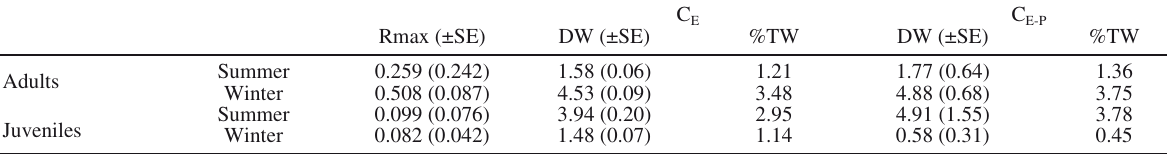
Table 3. – Estimates of gastric evacuation Rmax (h −1 ) and consumption rates C (DW 1000 g –1 wet BW) for sardine adults and juveniles in summer and winter. Consumption values are also expressed as percent total weight (%TW). DW, dry weight; C Eggers model; C , daily ration according to the Elliott-Persson E-P